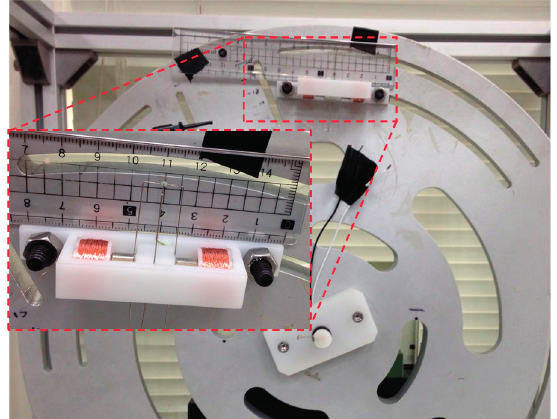
Figure 9. Prototype of the